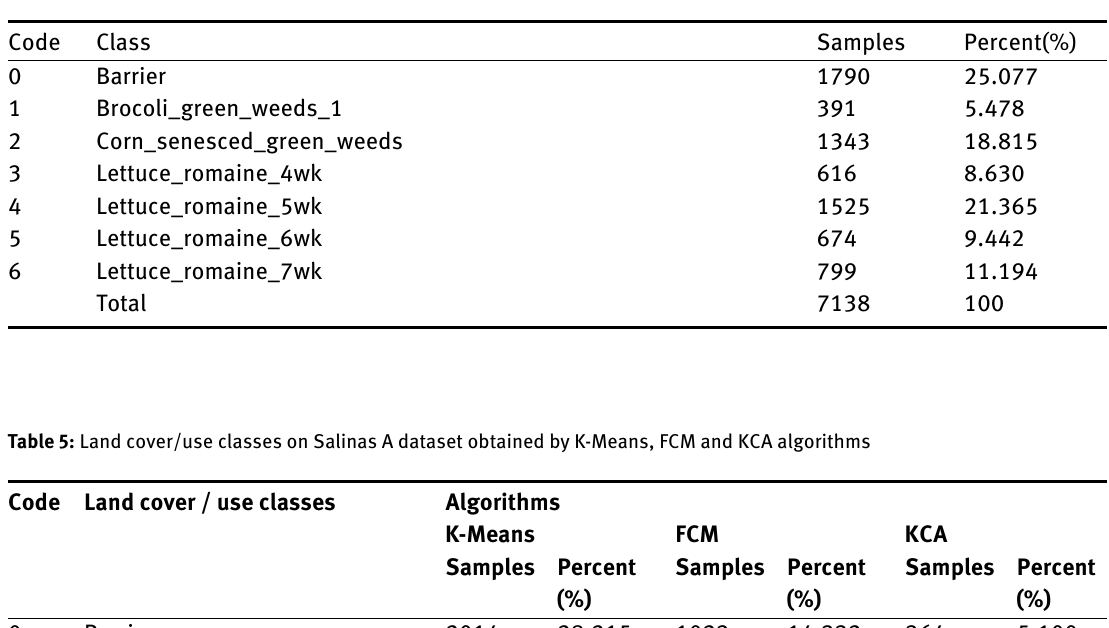
clusters for this data set. The ground truth class details for this data set has been shown in Table 4. Table 5 shows land cover classes as obtained by K-Means, FCM and KCA algorithms respectively.